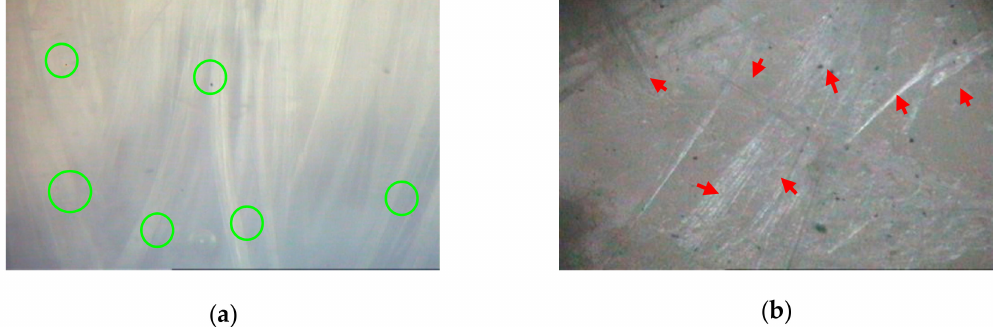
Figure 2. The optical morphologies of chrysotile fiber: ( a ) in bundle (green circles) ( × 200); ( b ) dispersed state in ethanol (red arrows) after grinding for 30 min ( ×